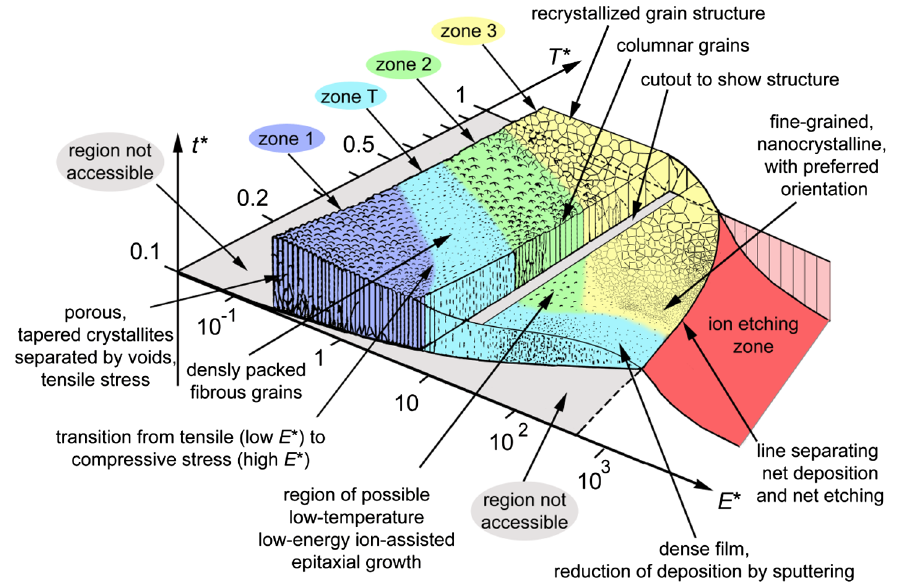
FIG. 1. Modified SZD diagram (reproduced from Ref. [9] with permission from the author and Elsevier Publishers). We notice a window of parameters where it is possible to achieve epitaxial